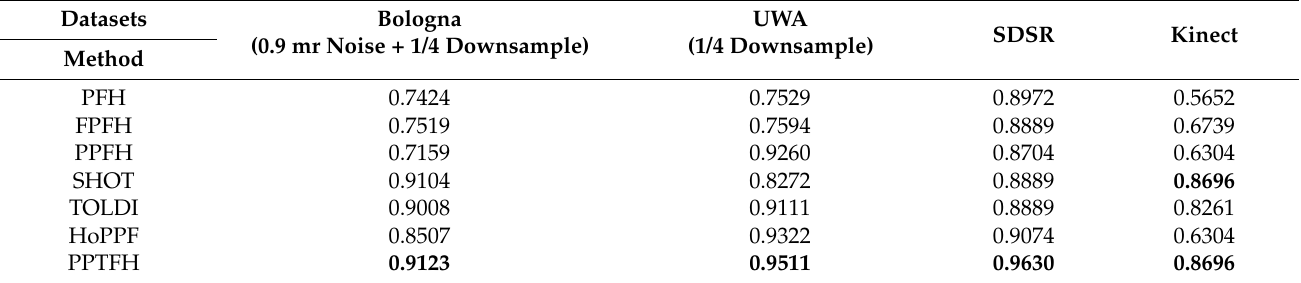
Table 6. The best surface matching performance ( F 1 scores) for different